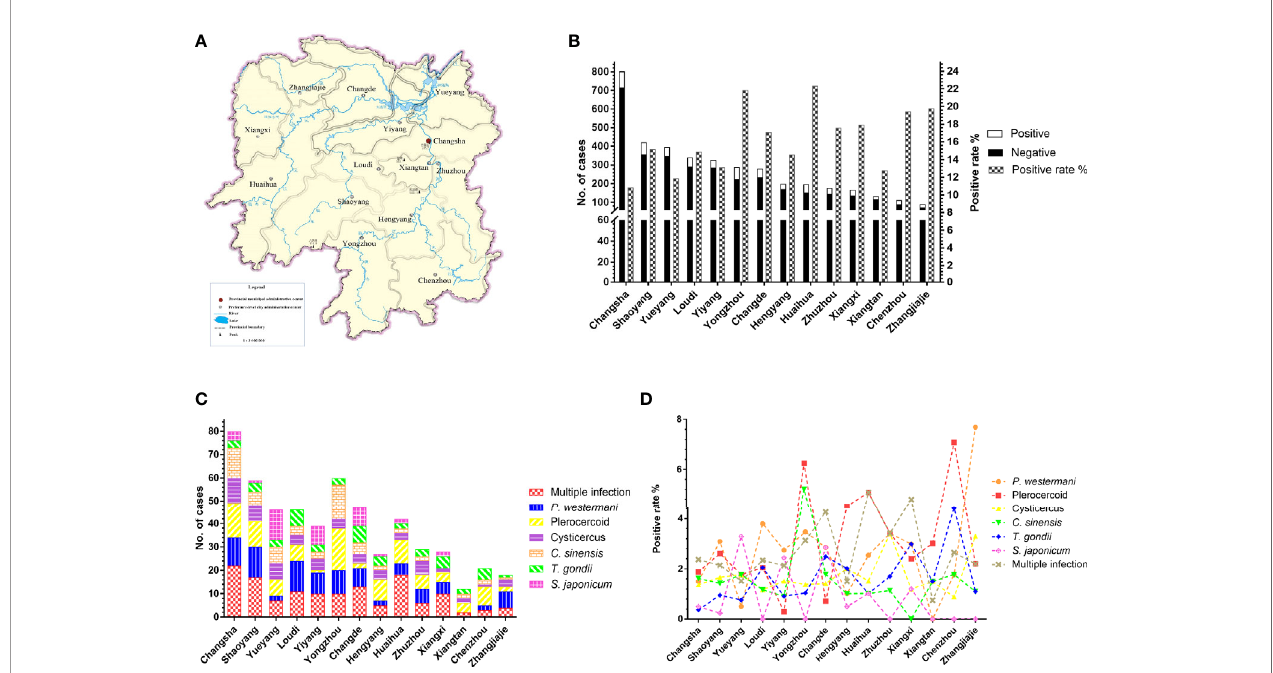
FIGURE 4 | Prevalence of parasites in different cities in Hunan Province, China. (A) The map of Hunan Province, China. (B) The number of patients and total parasitic positive rate in 14 cities. (C, D) Distribution and prevalence of several common parasites in 14